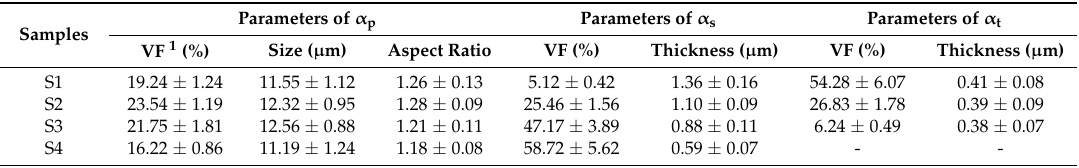
Table 2. Parameters of microstructural features in different samples.